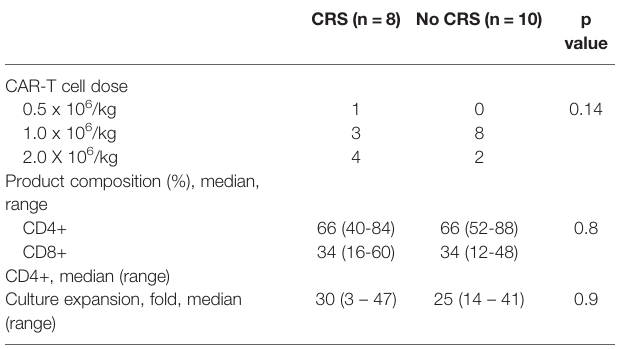
TABLE 2 | Cell product characteristics among patients with locally manufactured CAR-T cells (n = 18).